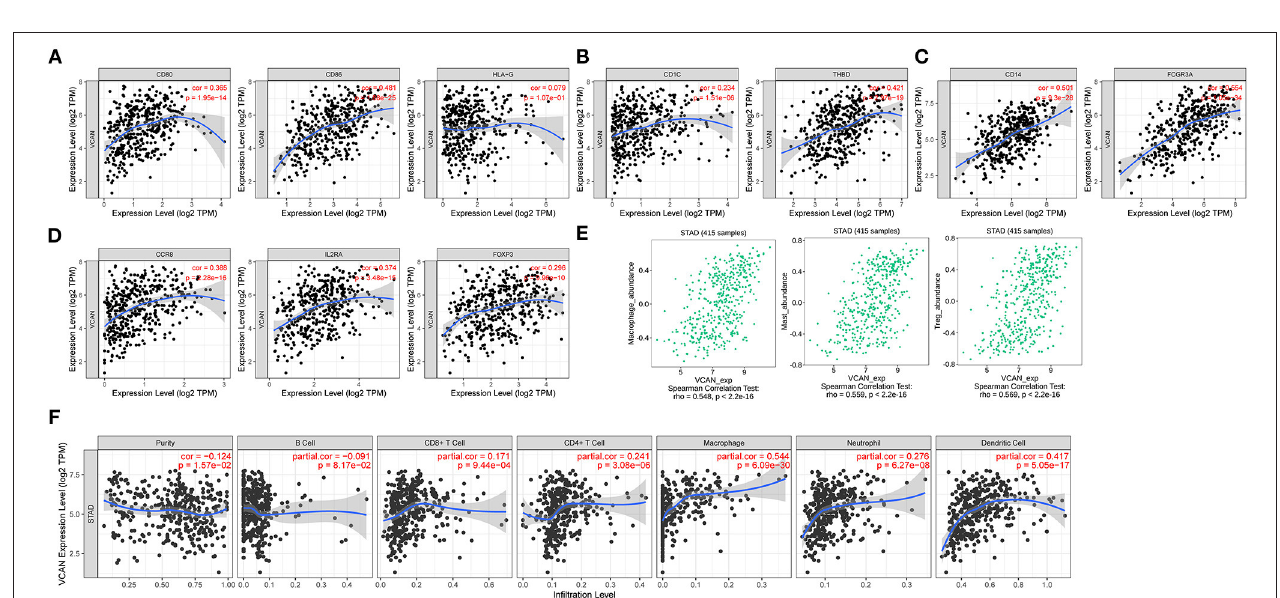
FIGURE 8 | Immune infiltration of VCAN. (A–C,E) Biomarkers of (A) dendritic cell, (B) monocyte, (C) tumor-associated macrophage (TAM), and (E) regulatory T cell (Treg). (D) VCAN expression is associated with the macrophage, mast cell, and Treg infiltration. (F) Major immune cells infiltration in the GC tissues is correlated with the VCAN